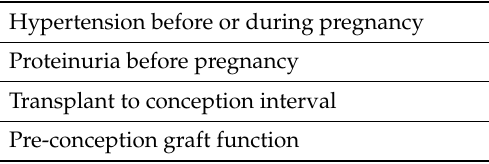
Table 5. Risks factors for graft loss after